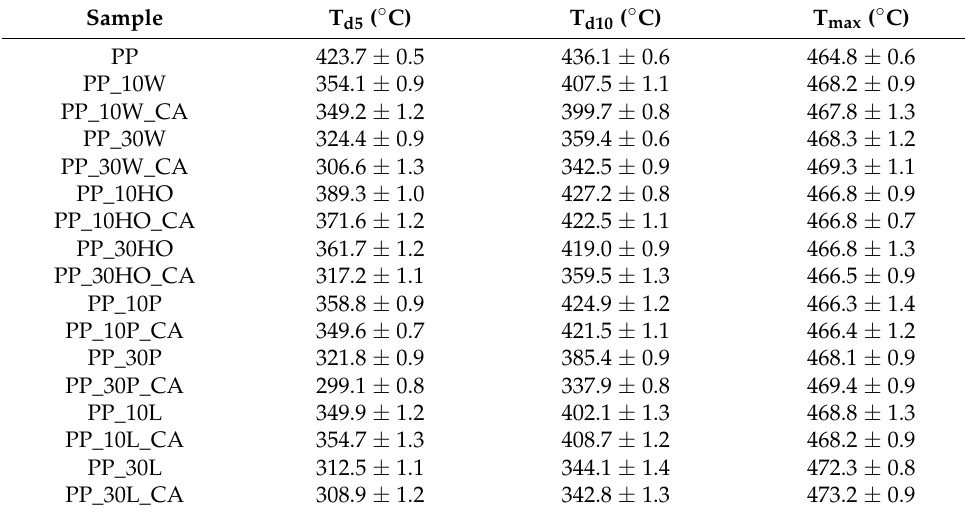
Table 4. Thermal parameters obtained from Figure 5.